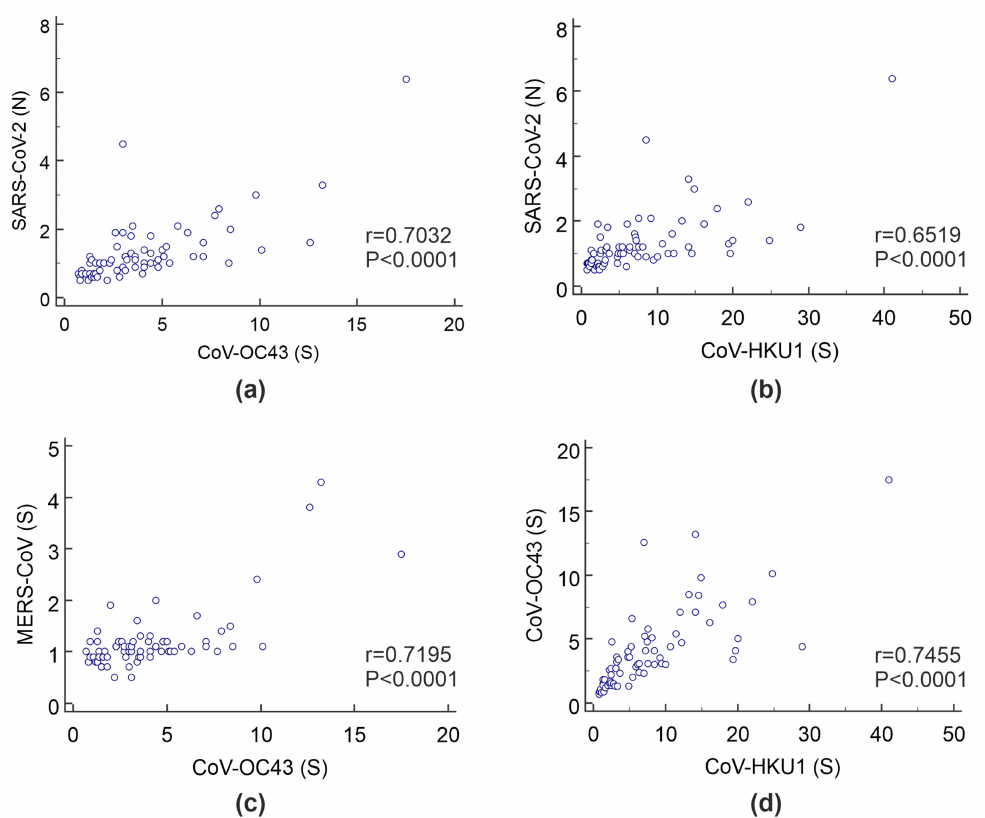
Figure 5. Scatter diagram for ( a ) IgG against SARS-CoV-2 (N) vs. IgG against OC43 (spike), ( b ) IgG against SARS-CoV-2 (N) vs. IgG against HKU1 (spike), ( c ) IgG against MERS-CoV (spike) vs. IgG against OC43 (spike), and ( d ) IgG against HKU1 (spike) vs. IgG against OC43 (spike) in the prepandemic cohort. The I n /I ref values are plotted along the two